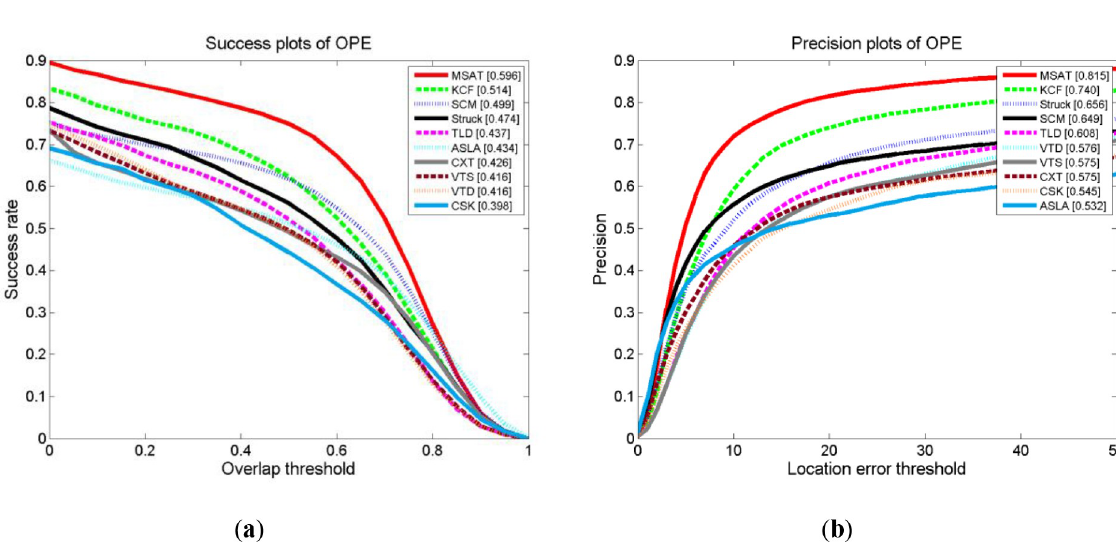
Fig 6. Success plots ( a ) and precision plots ( b ) of proposed tracker against the top nine performing state-of-art tracker[1,2,3,4,5,11,21,17,7,6] on the default 51 video sequence in Visual Tracker Benchmark[12].